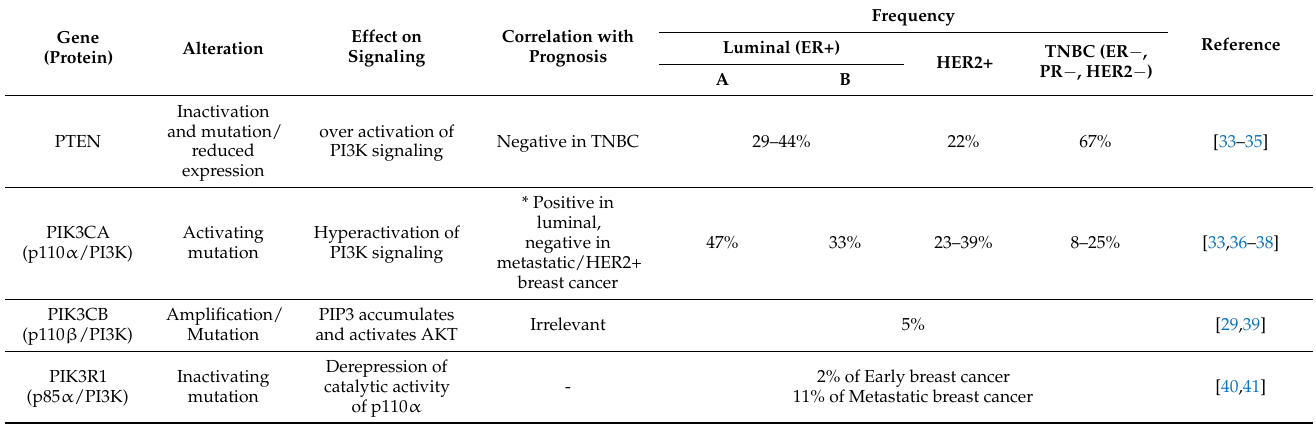
Table 1. Frequencies of changes of PAM pathway in different molecular subtypes of breast